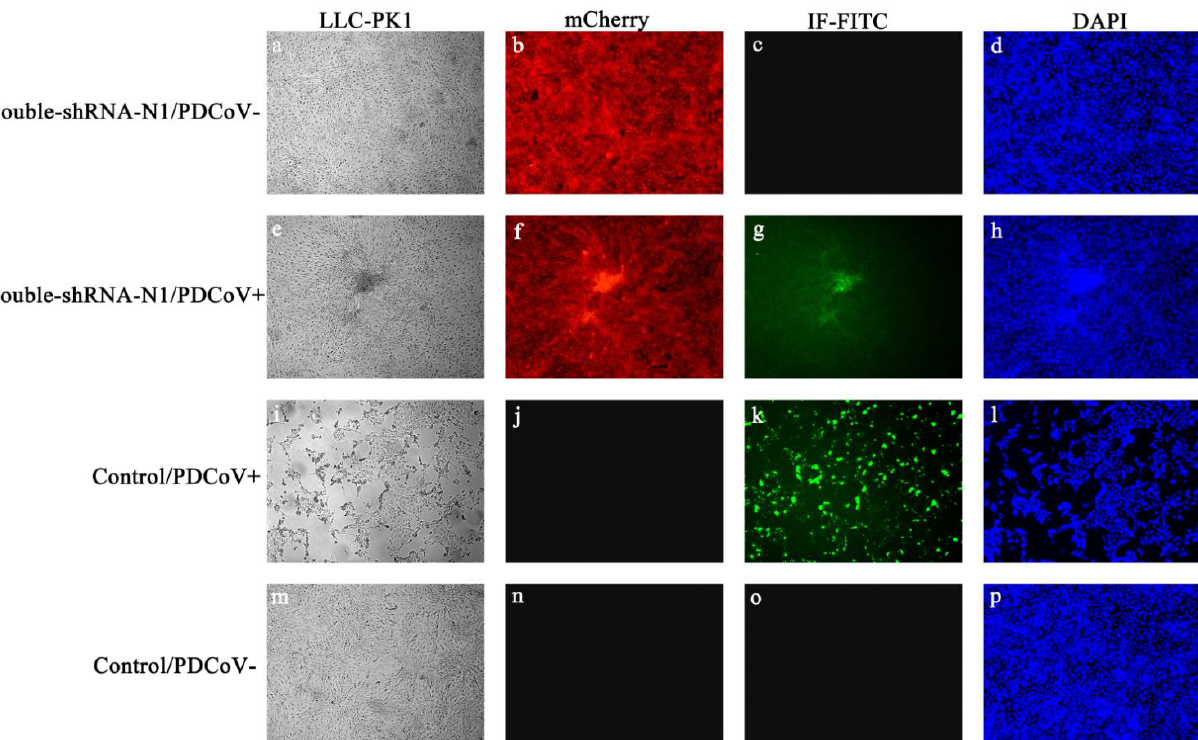
Figure 4. Effects of pSil-double-shRNA-N1-mcherry plasmids on PDCoV-induced CPE in LLC-PK1 cells by immunofluo- rescence assay. ( a – d ) pSil-double-shRNA-N1-mCherry stably transfected cells served as a mock transfection control; ( e – h ) pSil-double-shRNA-N1-mCherry stably transfected cells indicated a noticeable reduction of PDCoV N protein expression; ( i – l ) non-transfected cells indicated no obvious effects on PDCoV infection as a positive control; ( m – p ) non-transfected cells without PDCoV infection were used as a negative control. The green and red colors show the presence of PDCoV N protein-positive cells and stably shRNA-transfected cells, respectively. The nuclei of the cells were stained in blue by DAPI.